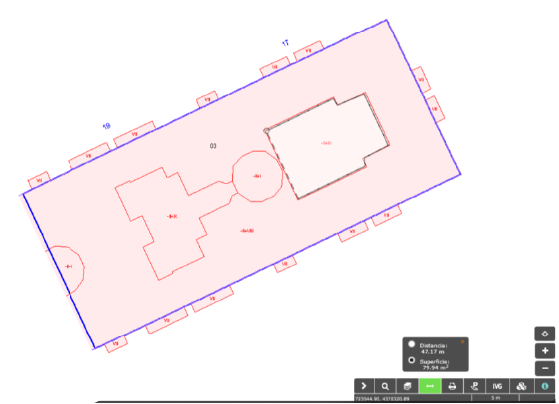
Figure 6. Measuring tool in the Cadastral Database (SEC, 2020). All the records corresponding to the same building (with the same block, plot and reference number) are condensed into a single record and transferred to the DB (still under construction at this stage) for the seismic risk assessment. The total built area of the building is calculated by adding the area of each